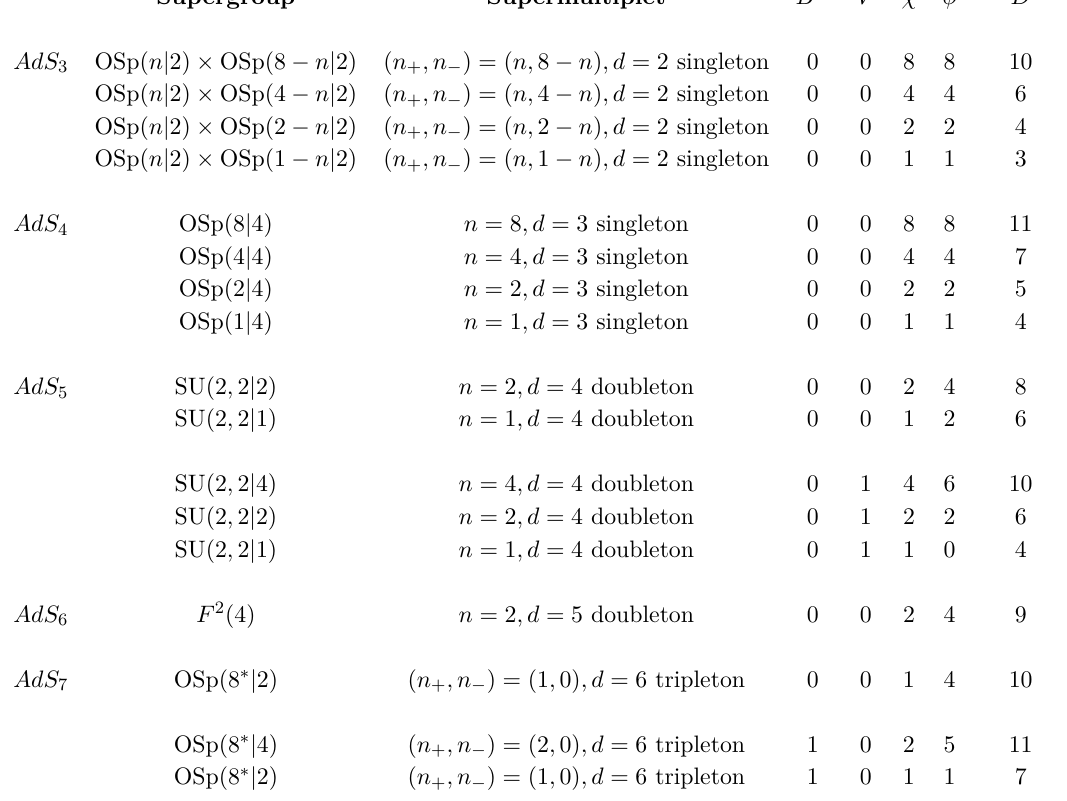
Table 2 . Superconformal groups and their singleton, doubleton and tripleton representations. B − , V , χ , φ denote the number of chiral 2-forms, vector, spinors and scalars in each multiplet. The spacetime dimension D equals the worldvolume dimension d plus the number of